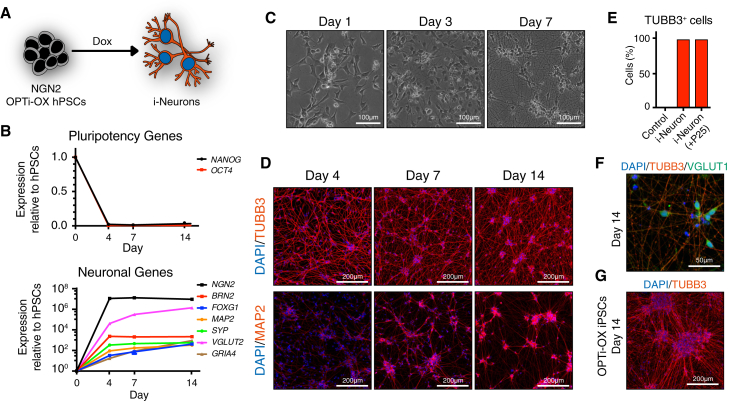
Forward Programming of hPSCs into Neurons(A) Experimental approach for conversion of NGN2 OPTi-OX hPSCs into i-Neurons.(B) Time course of i-Neuron generation from hESCs by qPCR demonstrating the expression pattern of pluripotency factors (OCT4 and NANOG), pan-neuronal (MAP2 and SYP), forebrain (BRN2, FOXG1), and glutamatergic neuronal marker genes (VGlut2, GRIA4) (n = 3 biological replicates; mean ± SEM; relative to PBGD and normalized to pluripotency).(C) Phase contrast images illustrating the morphological changes during i-Neuron generation (a corresponding time-lapse is shown in Movie S1).(D) ICC for the pan-neuronal marker proteins βIII-tubulin (TUBB3) and microtubule-associated protein 2 (MAP2) during the generation of i-Neurons.(E) Quantification of βIII-tubulin-positive neuronal cells by ICC after 1 week of induction. Undifferentiated cells were used as negative control, and numbers are reported for i-Neuron generation in newly isolated NGN2 OPTi-OX hESCs and after 25 passages.(F and G) ICC for neuronal markers in i-Neurons 14 days after induction.